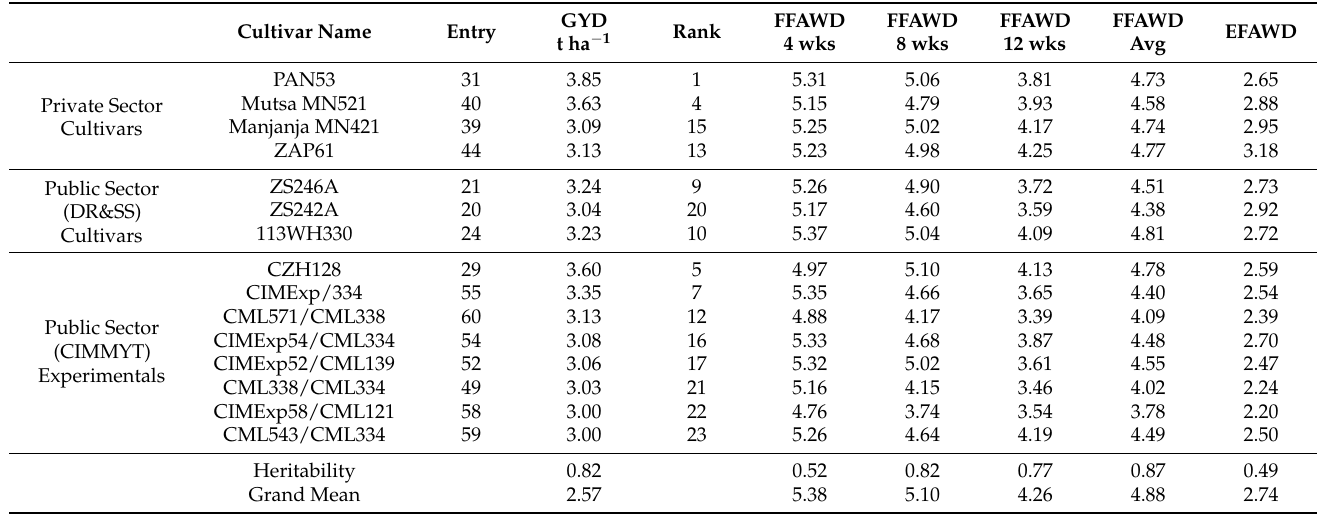
Table 5. Identified fall armyworm resistant genotypes with acceptable yield among the 60 entries evaluated across natural Fall armyworm infested sites in Zimbabwe during the 2019–2020